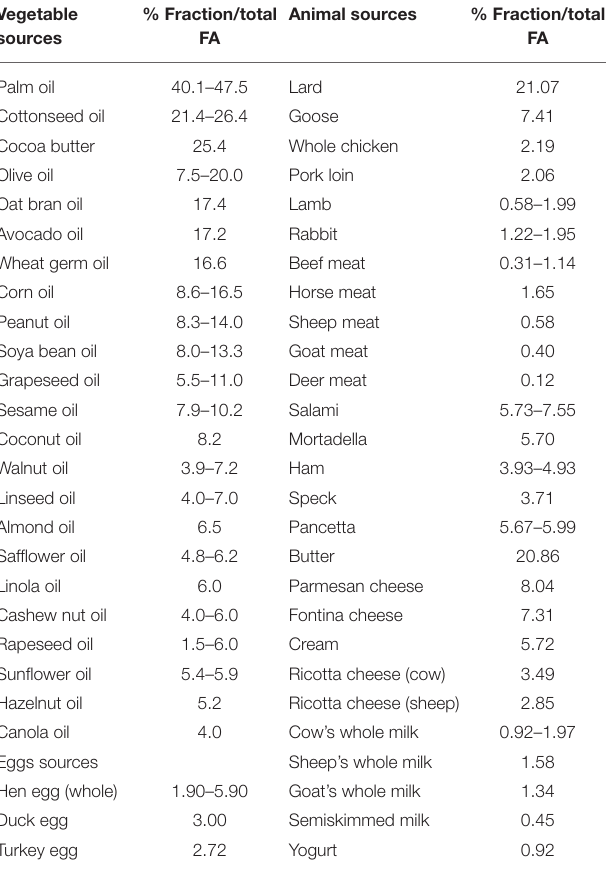
TABLE 1 | Palmitic acid content of oils and fats from vegetable and animal sources (expressed as percentage mass fraction of total FAs) (6). Vegetable